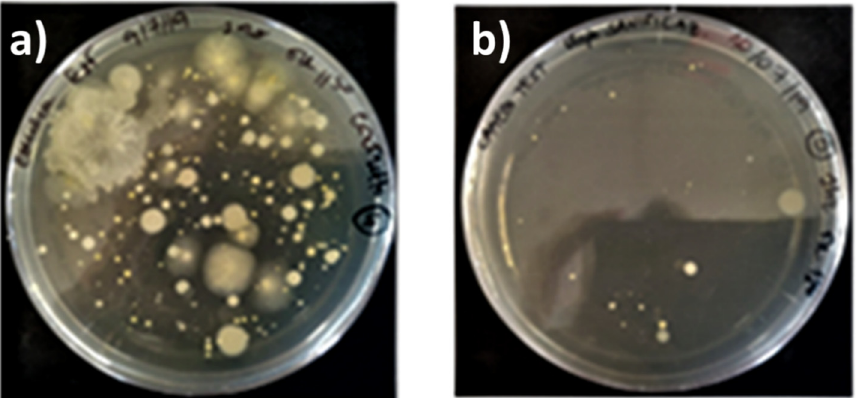
Figure 15. Growth of bacteria and mycelia recorded before ( a ) and after ( b ) the removal of resus- pended agricultural soil particles from the room with the SANINDOOR prototype system.